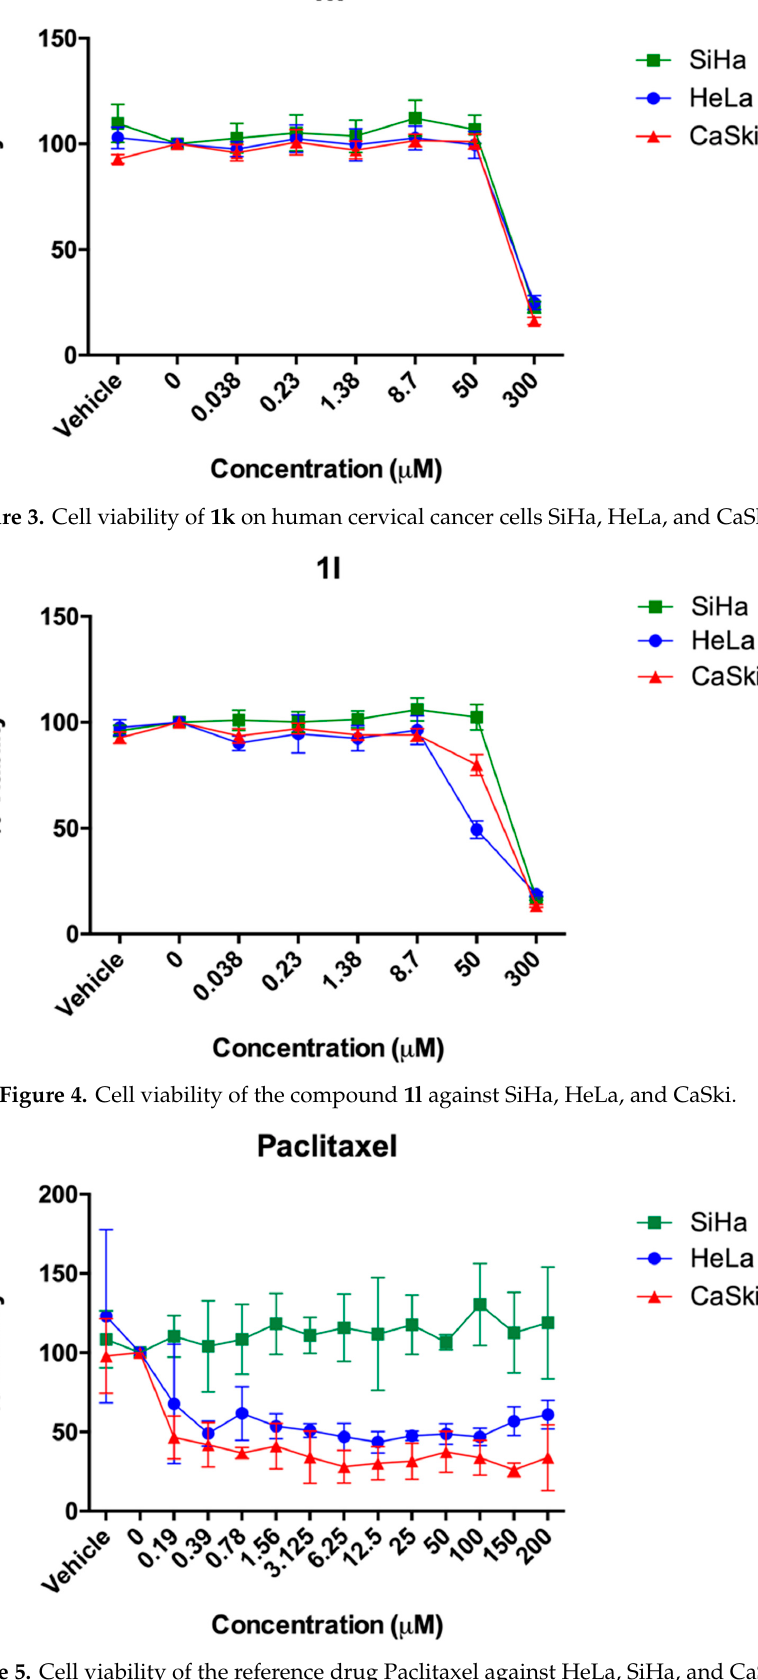
Figure 5. Cell viability of the reference drug Paclitaxel against HeLa, SiHa, and CaSki.